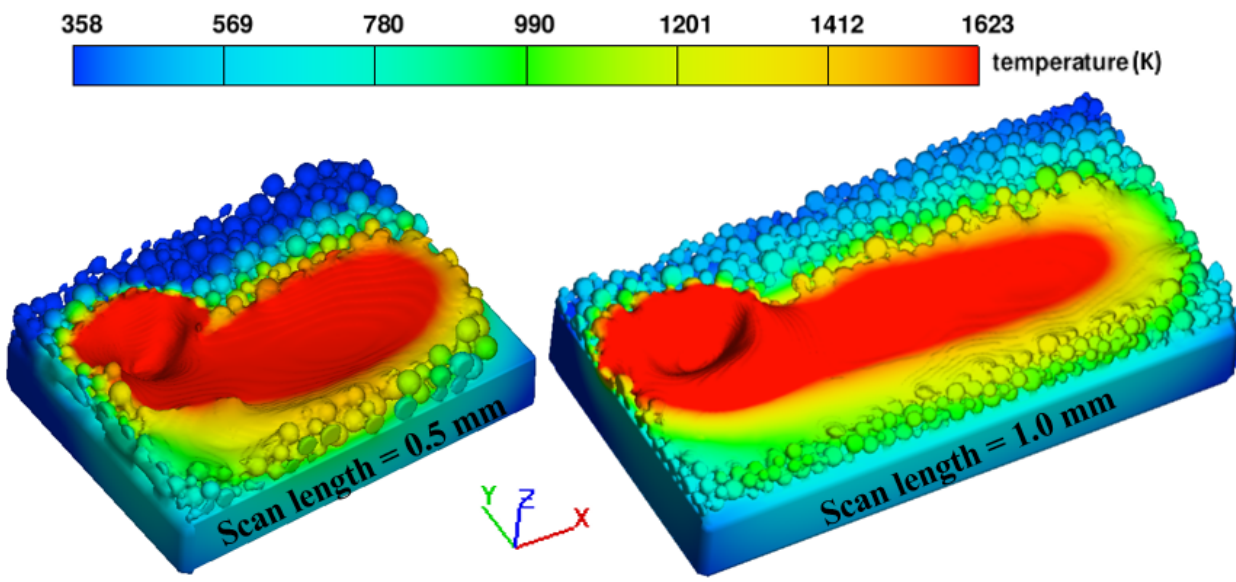
Figure 12. Temperature contours of the multi-track formed with 195 W laser power, 750 mm/s scan speed, 120 µm hatch spacing, and different scan lengths.